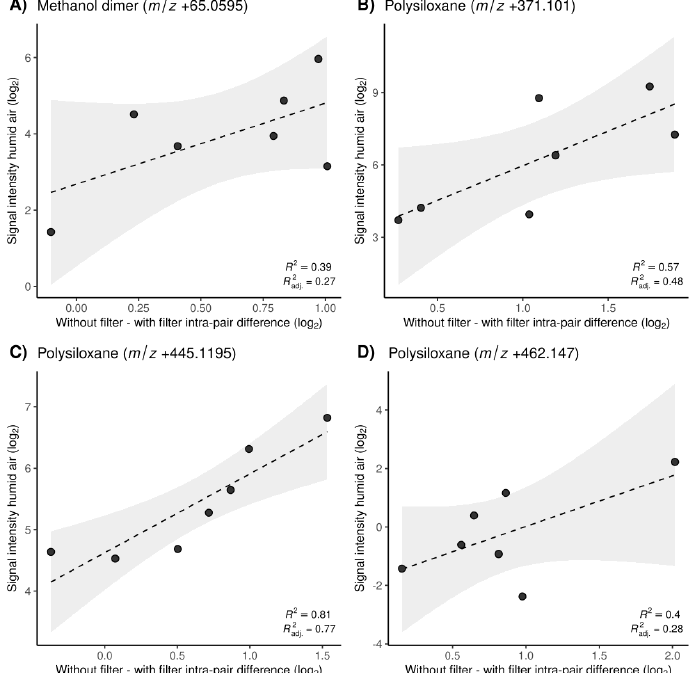
Figure 4. Plot of the m/z feature’s signal intensities in humidified ambient air samples on the y-axis vs. intra-pair signal intensity differences (without filter; with filter) on the x-axis. The paired observations were taken in the closest possible time proximity to the measured humidified air samples. The dashed line represents the regression line with a gray ribbon enclosed by the 95% confidence interval limits. ( A ) Methanol dimer ( m/z 65.0595), ( B – D ) polysiloxanes ( m/z 371.101, 445.1195, 462.147).